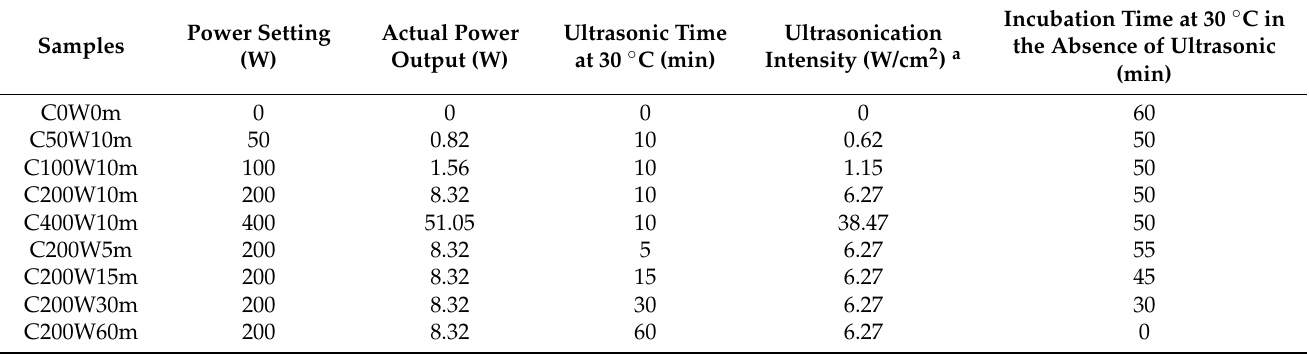
Table 1. Calorimetric study on VCX 750 ultrasonic probe and ultrasonication conditions for collagen